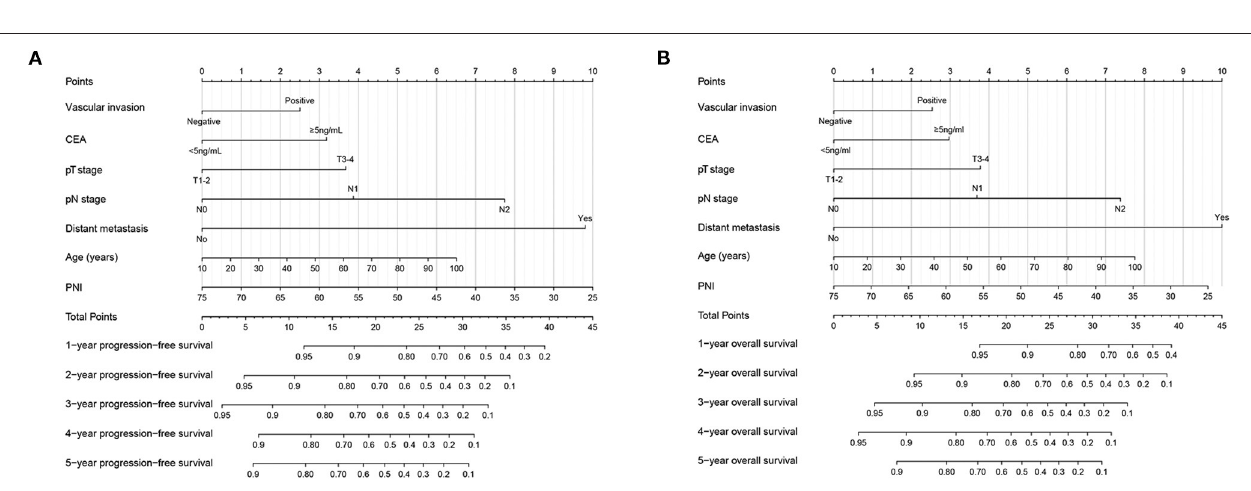
an effective prognostic indicator for various malignancy